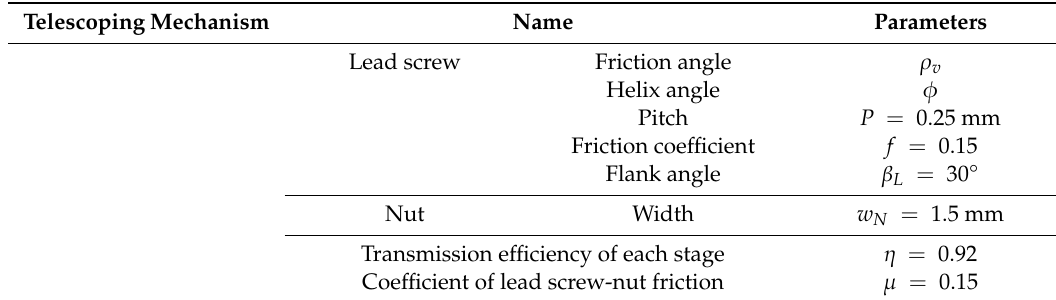
Table 3. The parameters of the telescoping